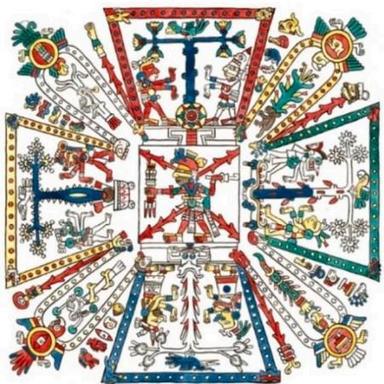
Example of image appearing in painted manuscripts such as the Codex Fej´ervary-Mayer ´ at the National Museums Liverpool, containing Maya Blue pigment and analogues. (image corresponding to "Detail of Codex F´ejervary-Mayer, also known as Codex Pochteca", drawn by Lacambalam (Reproduced from (, CC BY-SA 4.0). (For interpretation of the references to colour in this figure legend, the reader is referred to the web version of this article.)